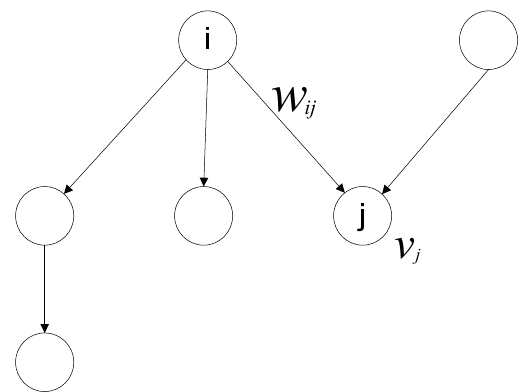
Figure 1. Representation of a cross-shareholding network as a weighted directed network.